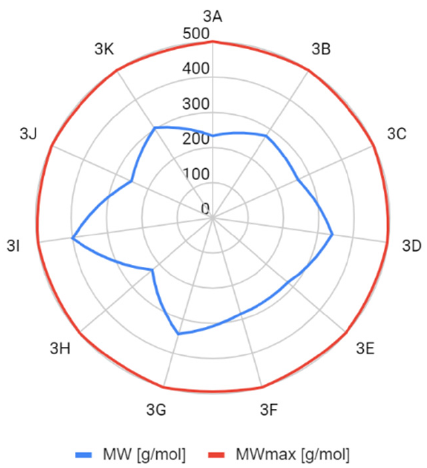
Figure 6. Molecular weight comparison (MWmax—maximum molecular weight value that satisfies Lipi ń ski’s rule).